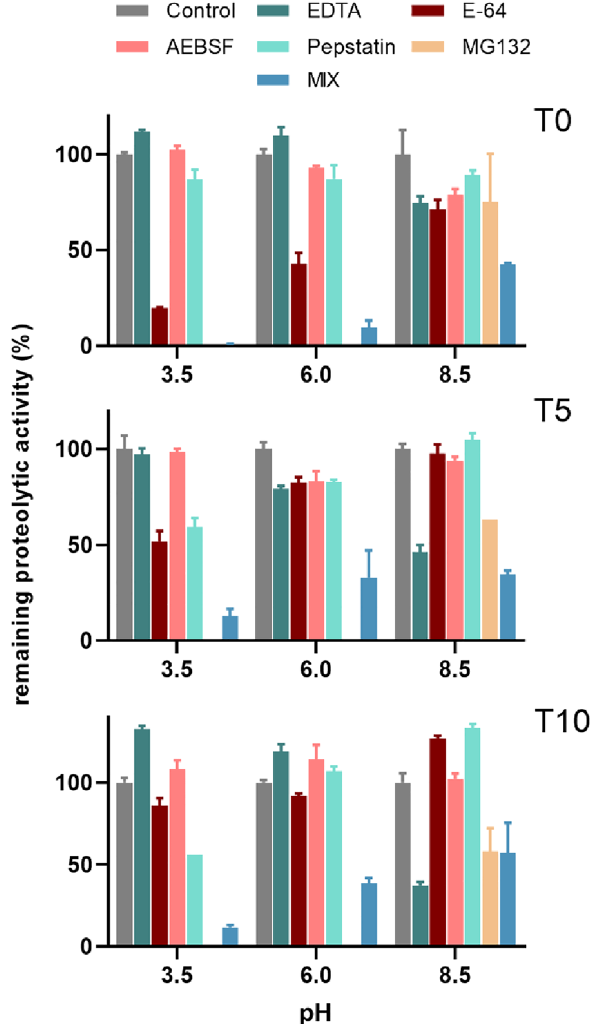
Figure 10. Inhibition of proteolytic activity in F. hepatica egg extracts using class-specific inhibitors. Proteolytic activity of protein extracts from F. hepatica eggs at 0, 5 and 10 days post laying (T0, T5 and T10, respectively) was assayed in the presence of class-specific inhibitors (EDTA, E-64, AEBSF, pepstatin, MG132) and a combination of all five inhibitors (MIX). Inhibitor of threonine peptidases (MG132) was used only at pH 8.5 due to its non-specific activity against cysteine peptidases in acidic environments. Inhibition of activity is expressed as the percentage of remaining proteolytic activity relative to a non-inhibited control (100%). Mean values are listed with standard